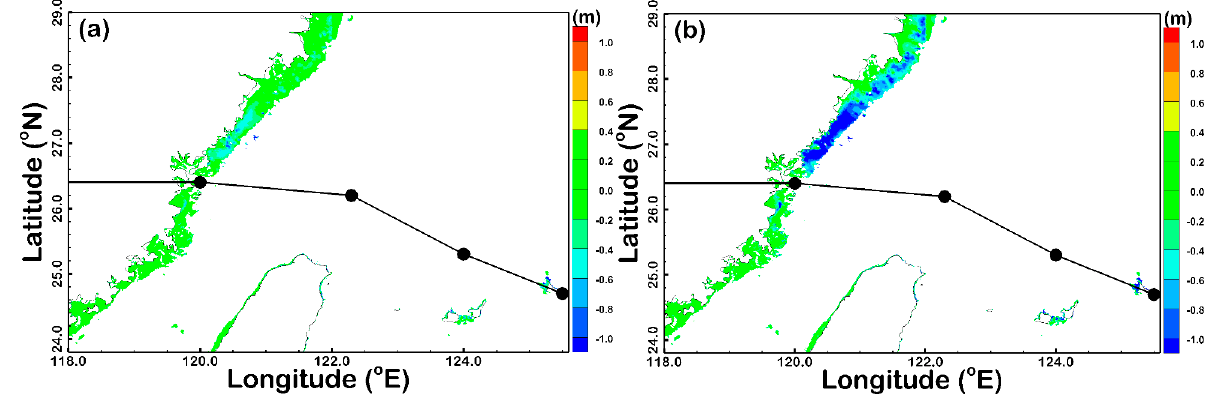
Figure 17. Spatial distribution of the difference in maximum SWH between the scenarios of ( a ) S_NO1 and S_NO2 and ( b ) S_NO1 and S_NO3 when Super Typhoon Maria (2018) made landfall on the southeast coast of China. The areas with water depths greater than − 20 m are shown.